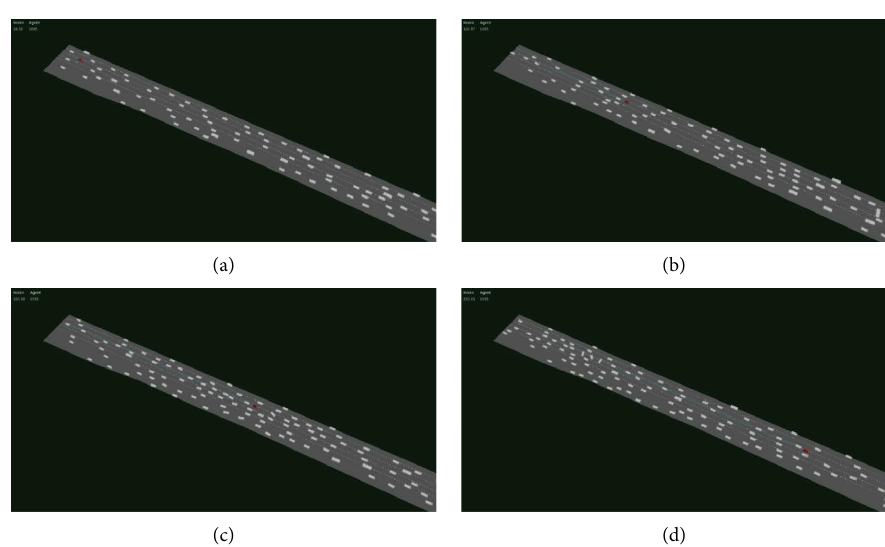
Figure 9: Simulation 1. (a) Keyframe 1. (b) Keyframe 2. (c) Keyframe 3. (d) Keyframe 4.